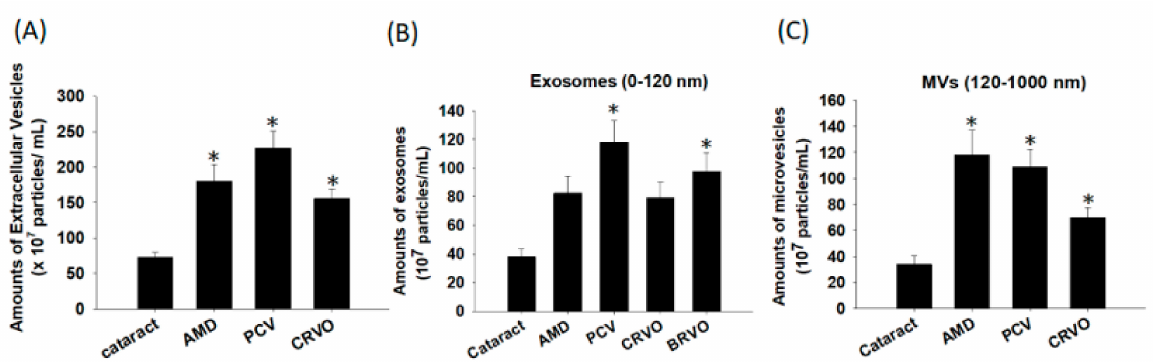
Figure 5. Amounts of microvesicles and exosomes in different retinal diseases. Extracellular vesicles (EVs) were isolated from the aqueous humor of patients with eye diseases, including cataracts, age-related macular degeneration (AMD), polypoidal choroidal vasculopathy (PCV), and central retinal vein occlusion (CRVO), and analyzed using nanoparticle tracking analysis (NTA). ( A ) The results showed the amounts of EVs in the aqueous humors. The EVs were classified into ( B ) exosomes (size of 0–120 nm) and ( C ) other microvesicles (MVs; size of 120–1000 nm). The data are expressed as the mean ± SE of 6–7 samples per group. * p < 0.05 compared to the cataract